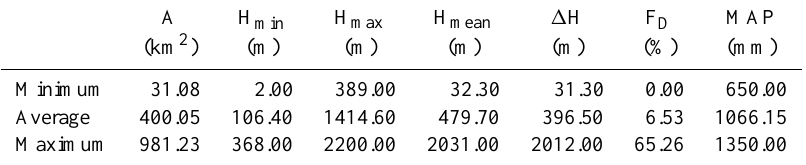
Table 2. Minimum, average and maximum values of the geomorphological and climatic indexes for the basins in the study region. A H min